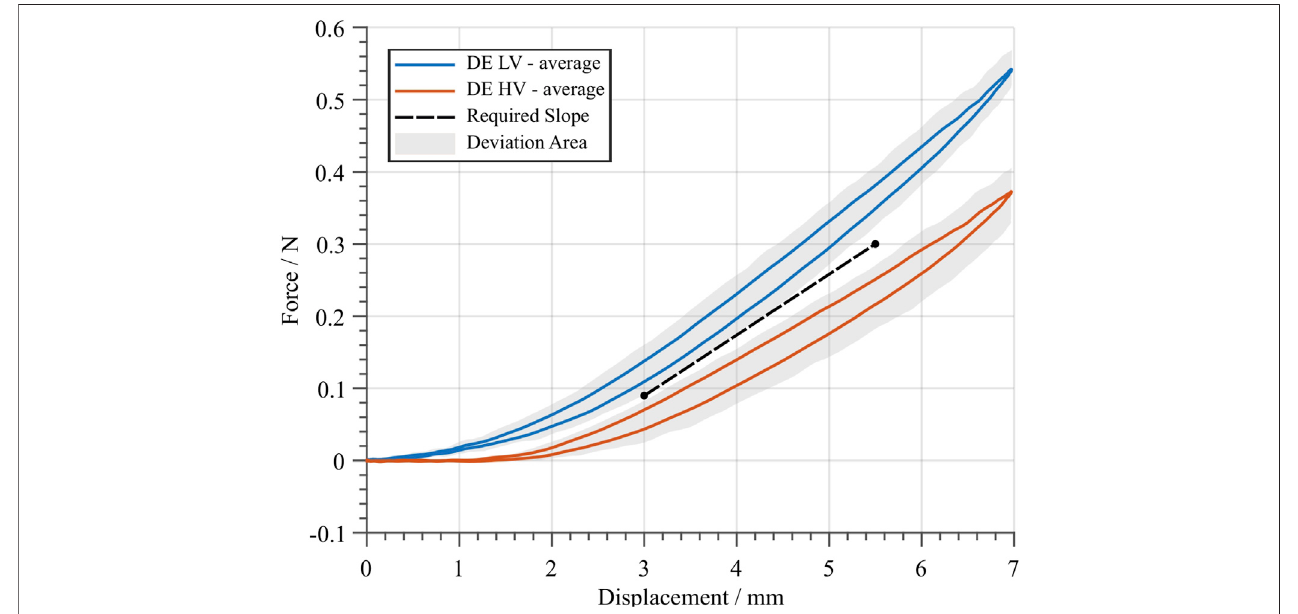
FIGURE7| Average DEcurves forthelow- (blue)and high-(red) voltage case, based ontheaveragebetweenfourdifferentspecimens. Asine-wave displacement pro fi lewithanamplitudeof7mmandafrequencyof0 . 1Hzwasappliedduringtheexperiments.Thegrayareadenotesthedeviationamongthefourmeasuredsamples. The black dashed line represents the required stiffness k req of an ideal biasing system, which would lead to a large stroke performance. For the average DE curves, the slope of this line equals k req (cid:1) 0 . 084N / mm.